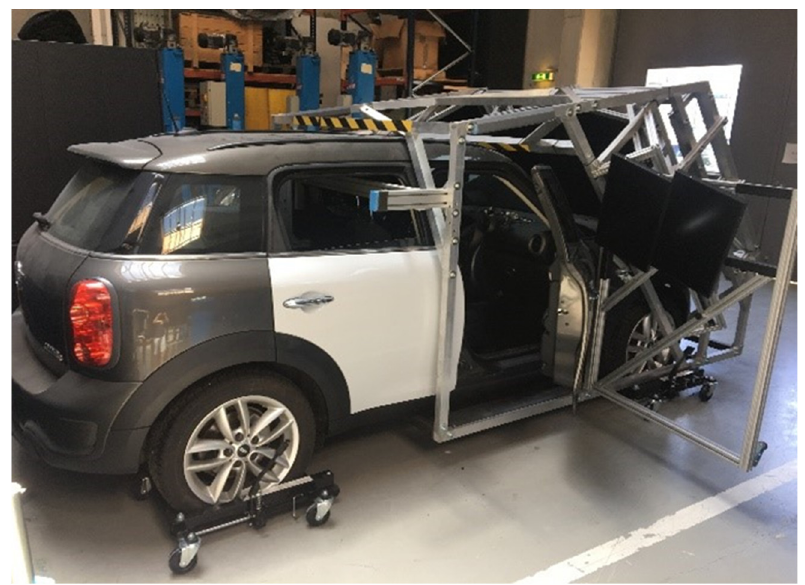
Figure 1. Automated Driving Simulator of Graz (ADSG). During the WACHSens project and to cancel the disturbing noise of the surrounding area and adjust the indoor temperature, ADSG is placed inside an insulating wooden cube. This figure is reprinted from our previous open-access work [38].